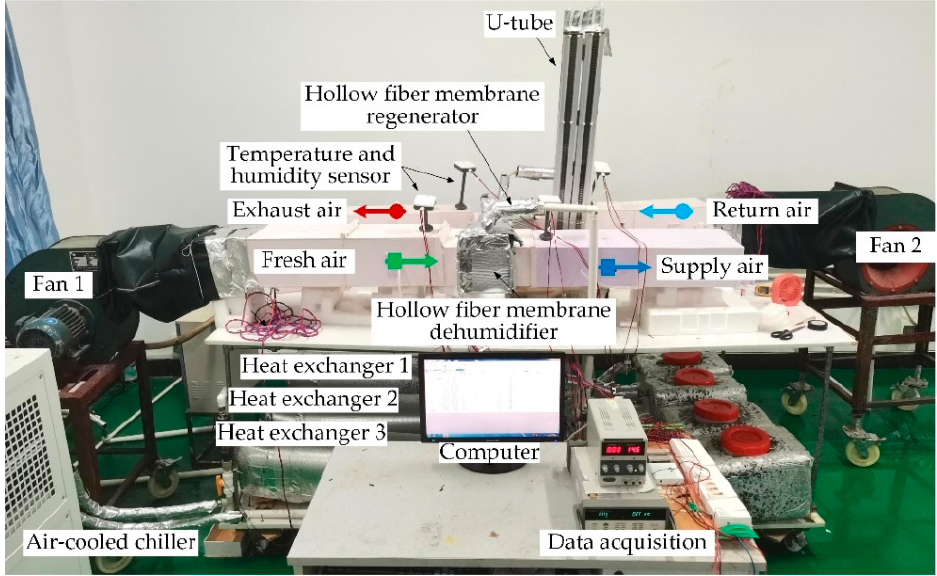
Figure 2. The hollow fi ber membrane dehumidi fi cation system experimental rig.